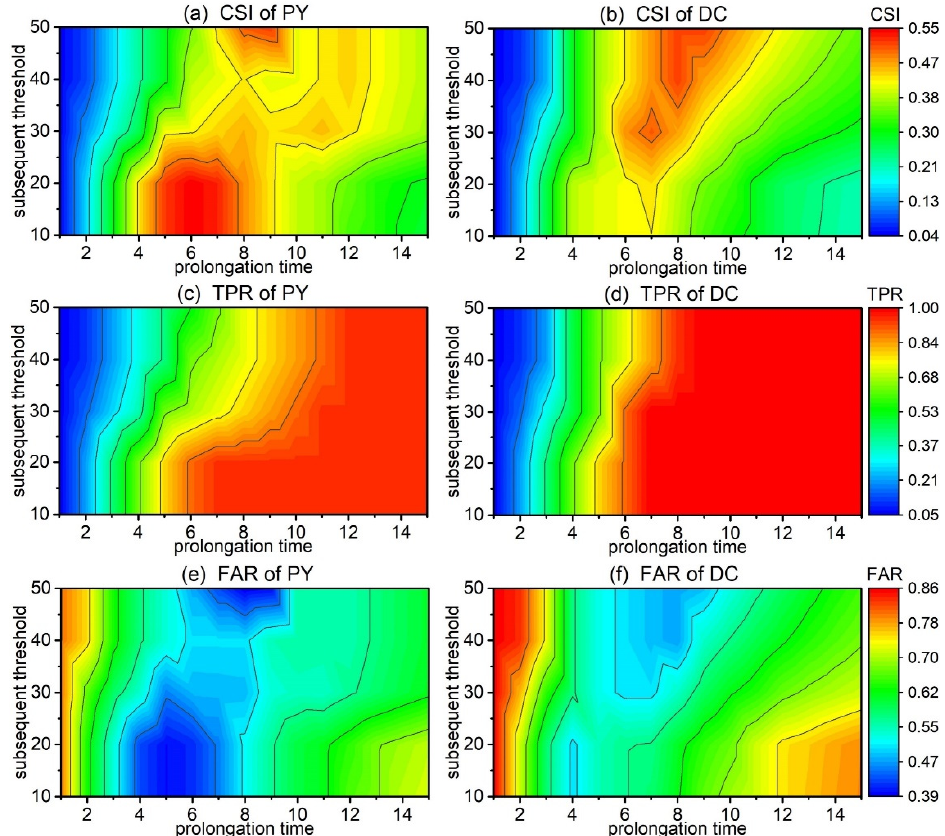
Figure 6. Variations in CSI ( a , b ), TPR ( c , d ), and FAR ( e , f ) as a function of the subsequent threshold and prolongation time. The values of the PY station are plotted on the left panels and those of the DC station are on the right panels.